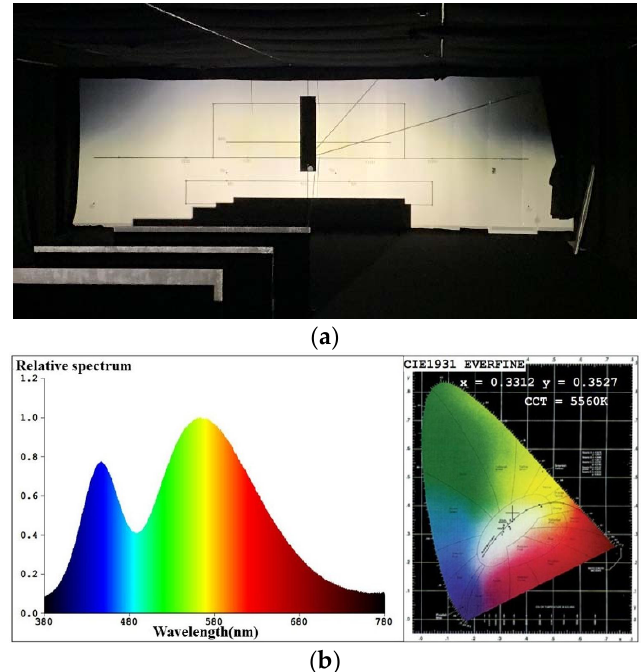
Figure 19. ( a ) The lighting spot and ( b ) test results of color of the point HV for high beam.